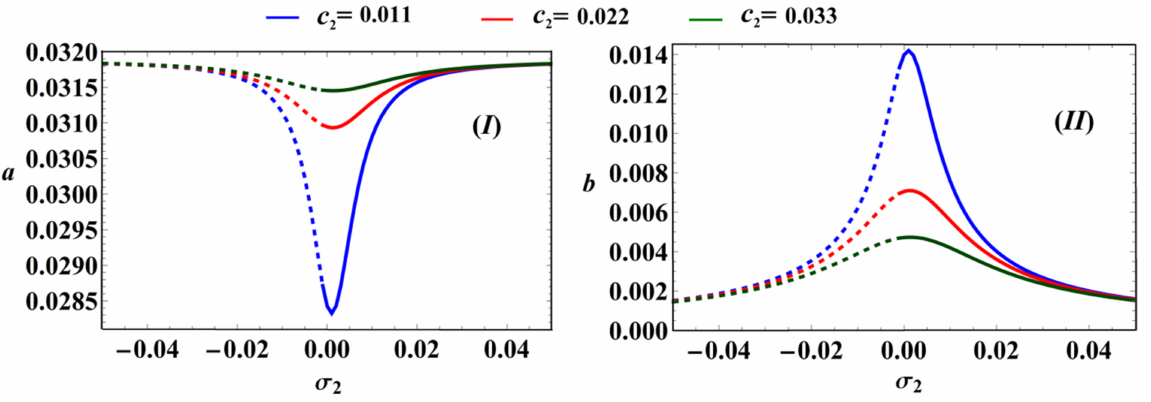
Figure 14. The frequency response of: ( I ) a ( σ 2 ) and ( II ) b ( σ 2 ) when σ 1 = 0, W = 0.448, and c 1 =